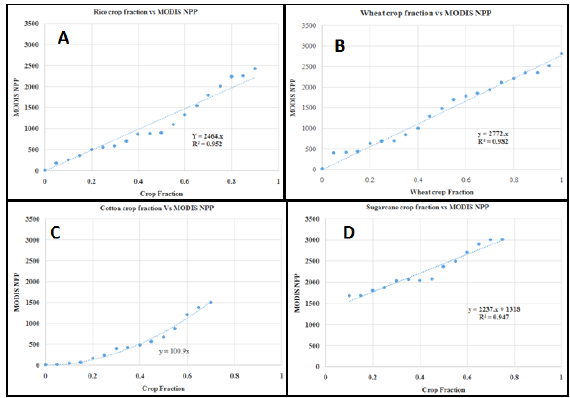
Fig. 3.2 Contribution of different crop fraction towards MODIS (A) rice, (B) wheat (C) cotton, (D)